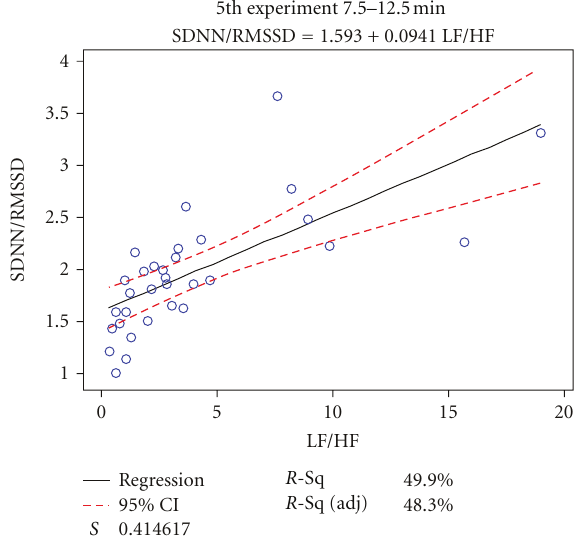
Figure 2: Calculation of the Pearson correlation coe ffi cient of SDNN/RMSSD and LF/HF. The period of sampled epoch is 5 mi- nutes and the number of subjects is 32. The correlation coe ffi cient r is determined by the slope of the regression line and the determina- tion coe ffi cient R-